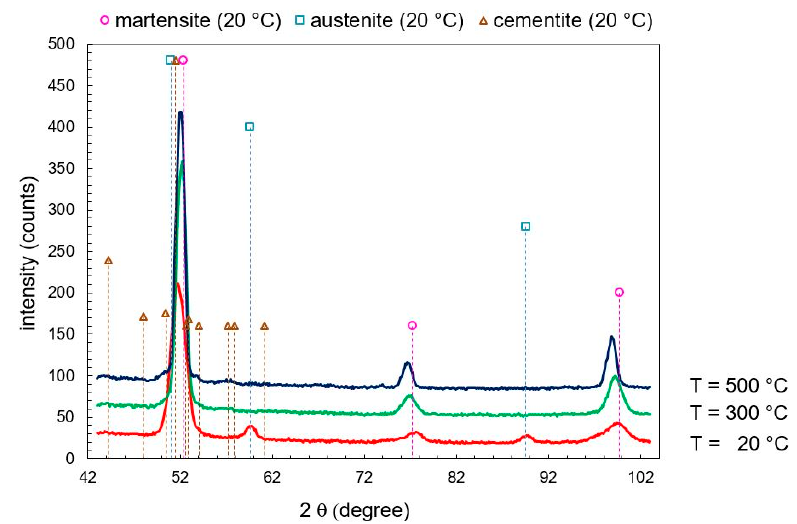
Figure 2. Diffraction patterns at 20, 300, and 500 °C from in-situ X-ray diffraction (XRD) for SAE 52100.